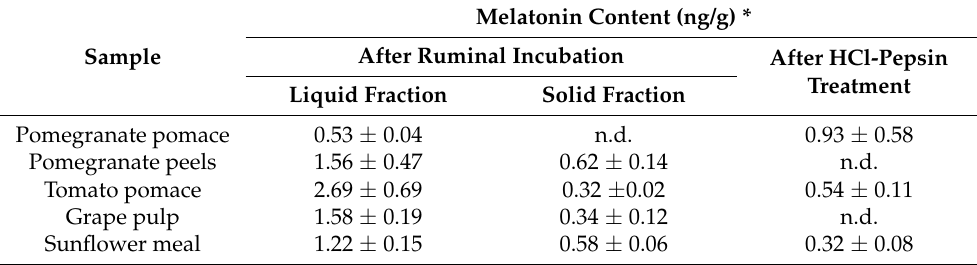
Table 2. Melatonin content in by-products after in vitro